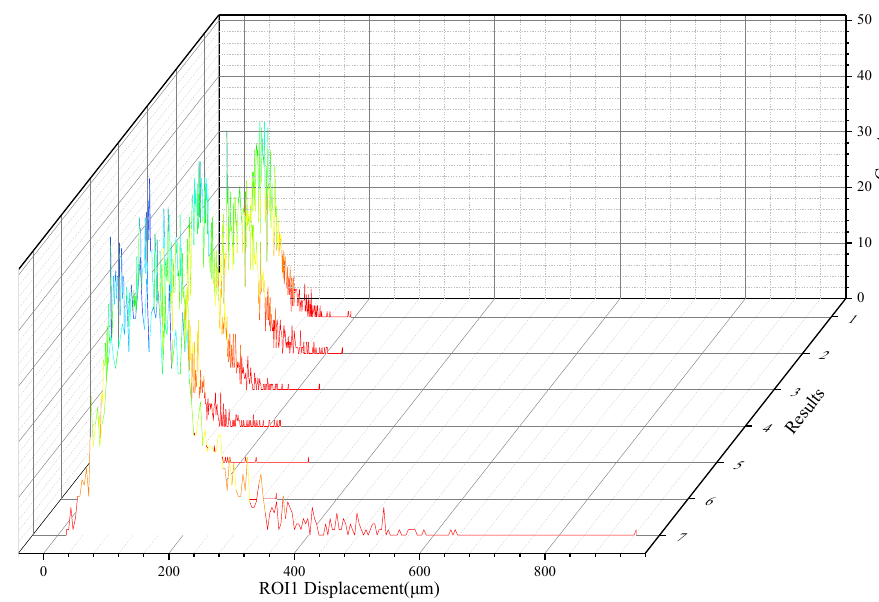
Figure 9. Statistical results for the ROI1 displacement field at different stages (stage 2 to 8).